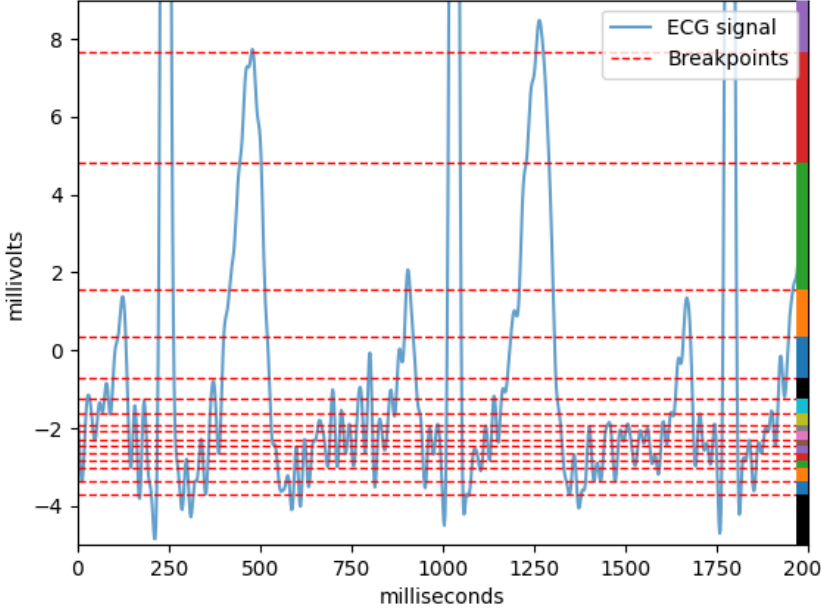
Figure 2. Quantization scheme example on two seconds of ECG signal. The ECG signal is represented by a blue line and the red dashes represent the breakpoints learned by the Lloyd–Max quantizer for this two second interval. The colors on the right are merely illustrative to help visualise the different intervals. Each interval represents a different symbol used after the quantization is done, i.e., when each sample on the signal is replaced by the corresponding symbol from the quantization interval it belongs